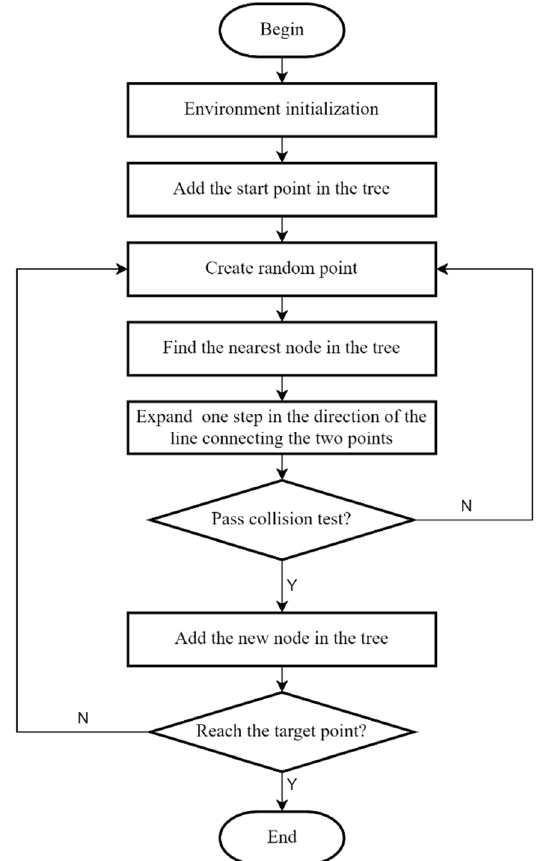
Figure 3. RRT algorithm flow.